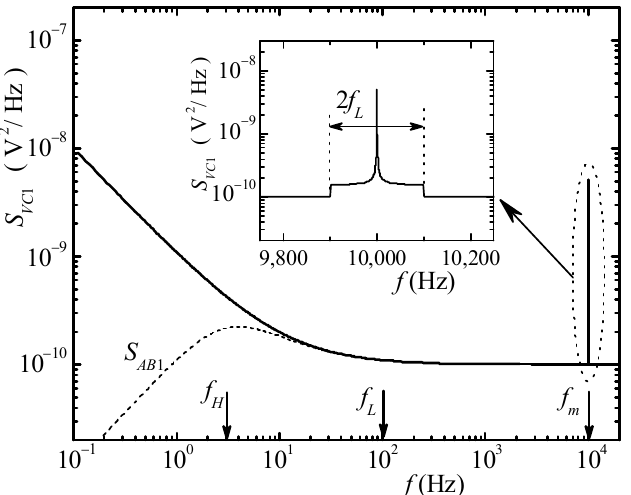
Figure 2. Calculated spectra illustrating the operation of the system. The black line represents the PSD of the signal vc1, while the dotted curve represents the spectra that would be obtained because of the high-pass filter at the input of the audio board. The inset represents the PSD close to the carrier frequency as the result of the operation in the front-end board.